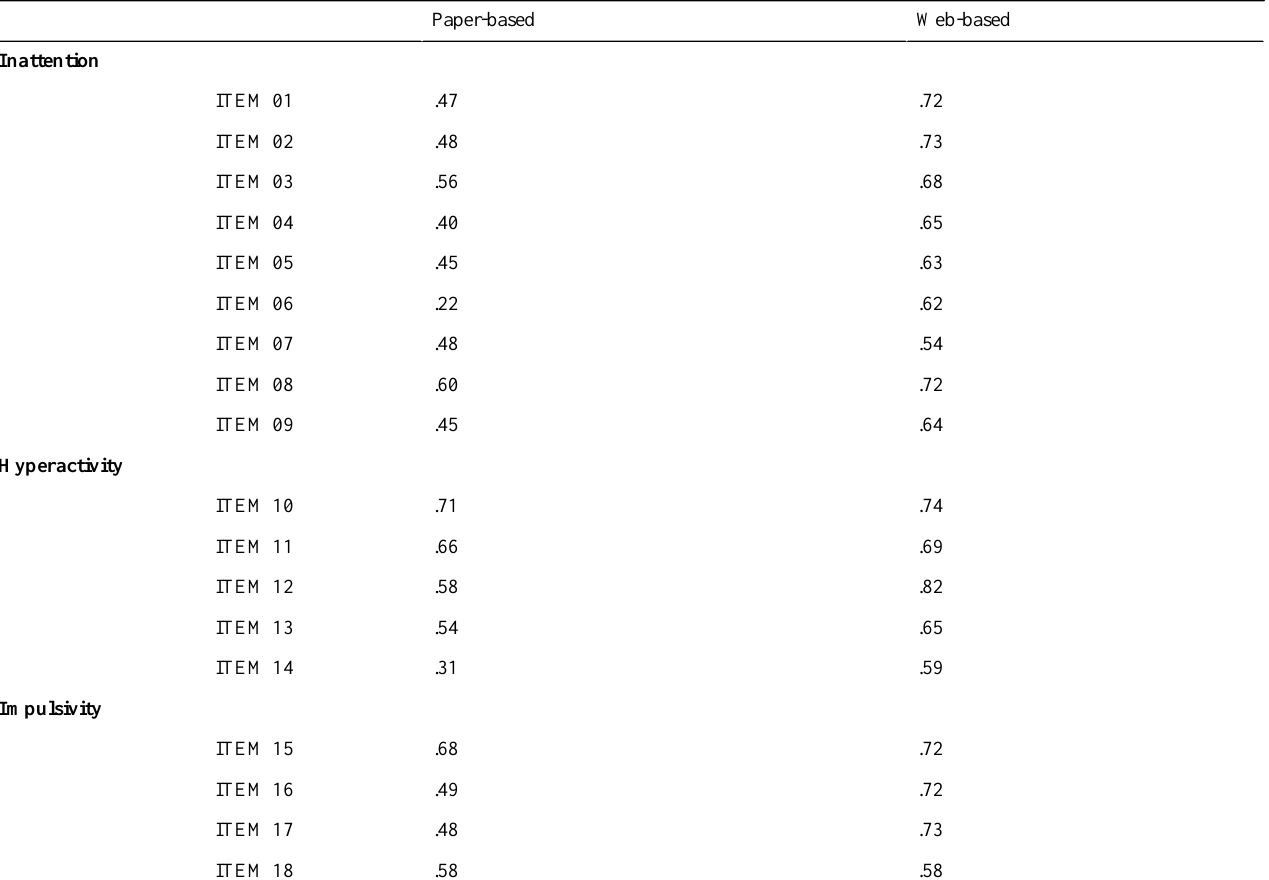
Table 7. Correlations of ADHS-SB items (loadings) with their postulated factors (latent constructs) in the paper-based and Web-based samples. Web-basedPaper-based